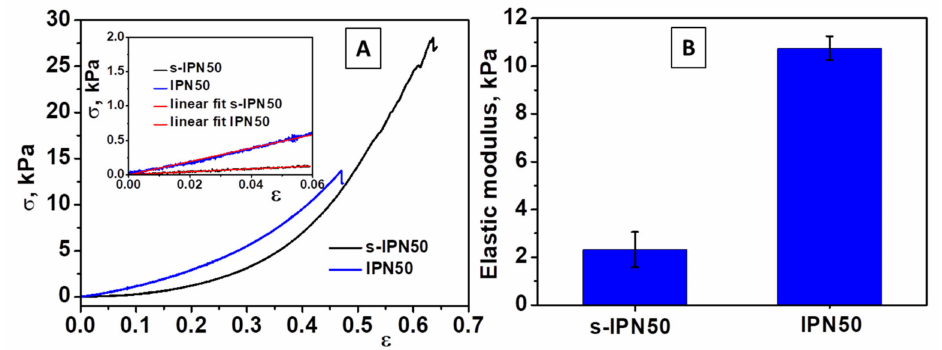
Figure 6. ( A ) Stress − strain curves obtained upon uniaxial compression onto s-IPN50 and IPN50 cryogels (inset: the linear dependence of stress − strain curves from which the elastic moduli were determined); ( B ) The values of modulus of elasticity of s-IPN50 and IPN50